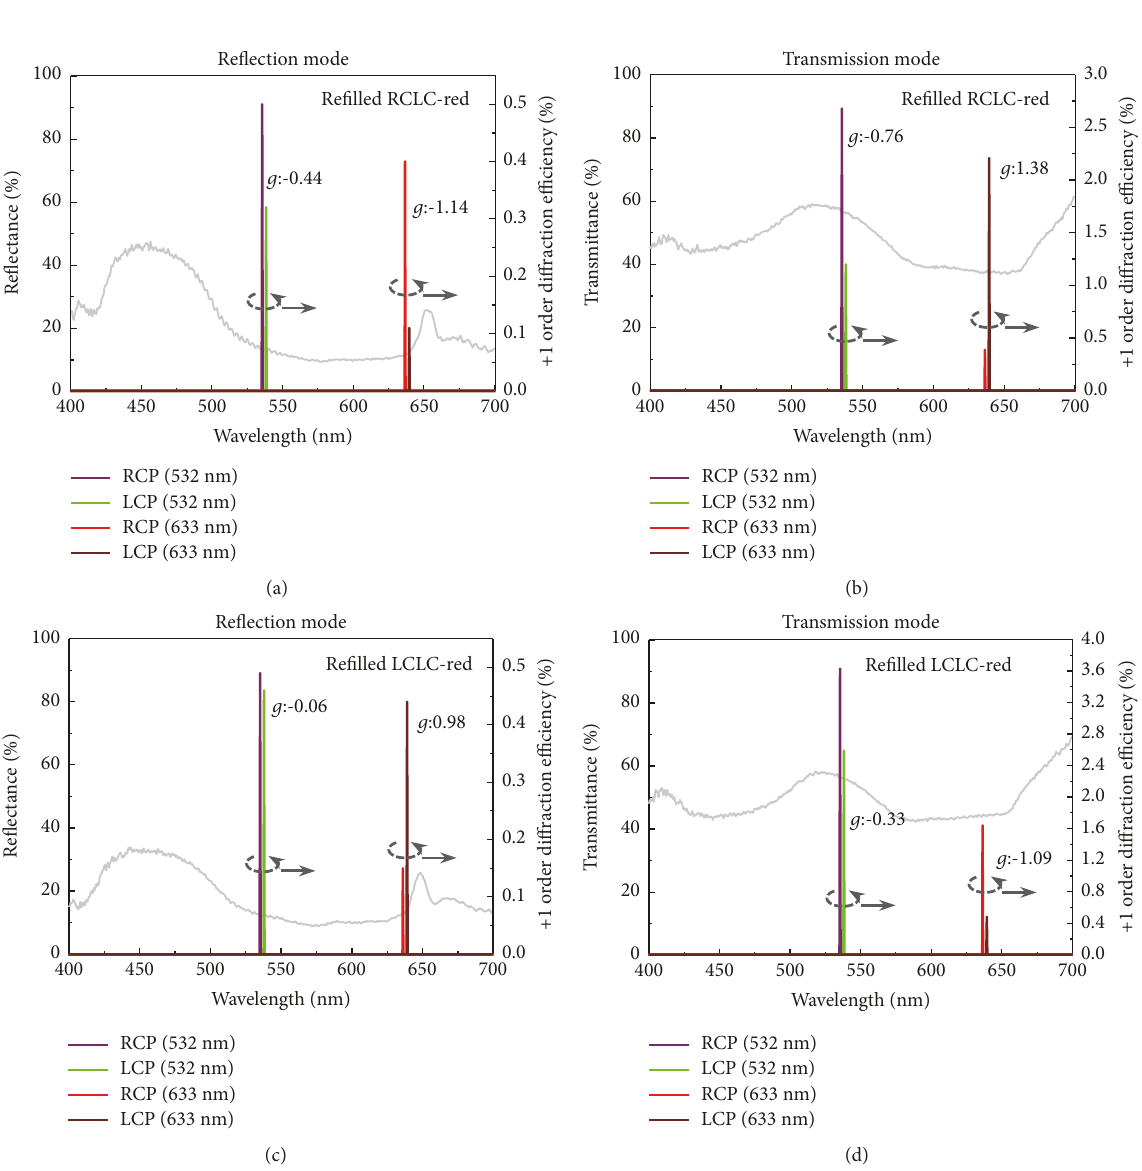
Figure 1: Setup for measuring the diffraction efficiencies of the refilled CLC template grating sample in reflection and transmission modes of diffraction beams.